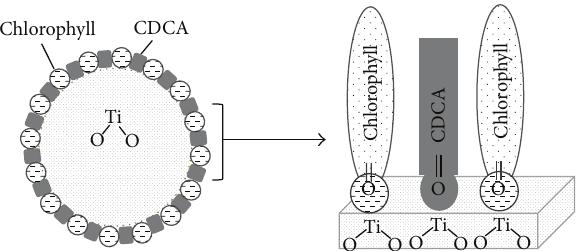
Figure 10: Schematic diagram of adsorption of Chlorophyll and CDCA molecule on TiO 2